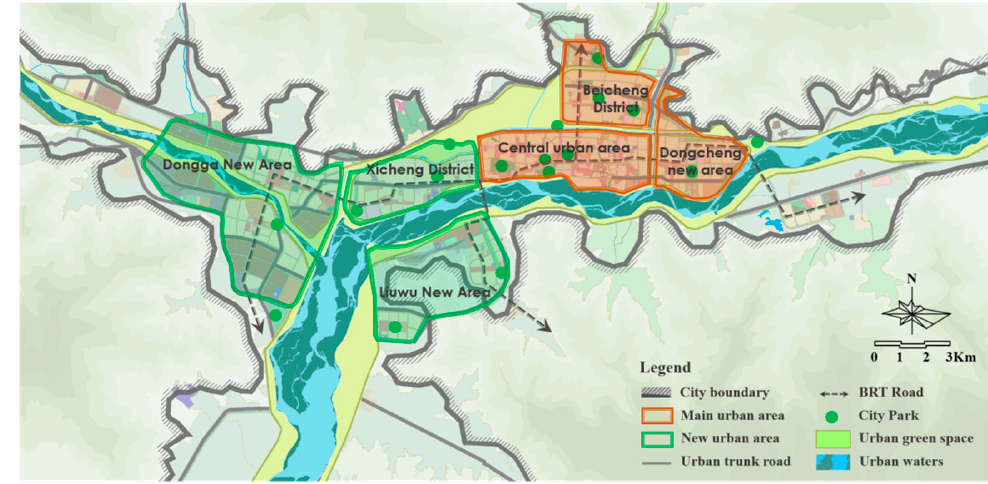
Figure 1. City map of Lhasa.